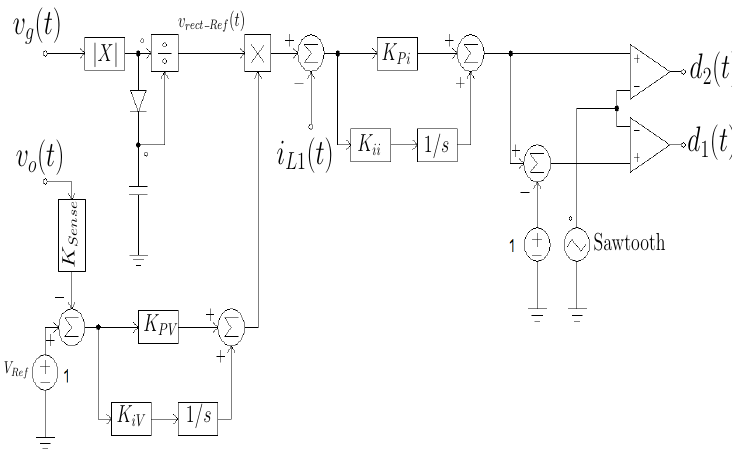
Figure 16. Controller circuit schematic diagram.